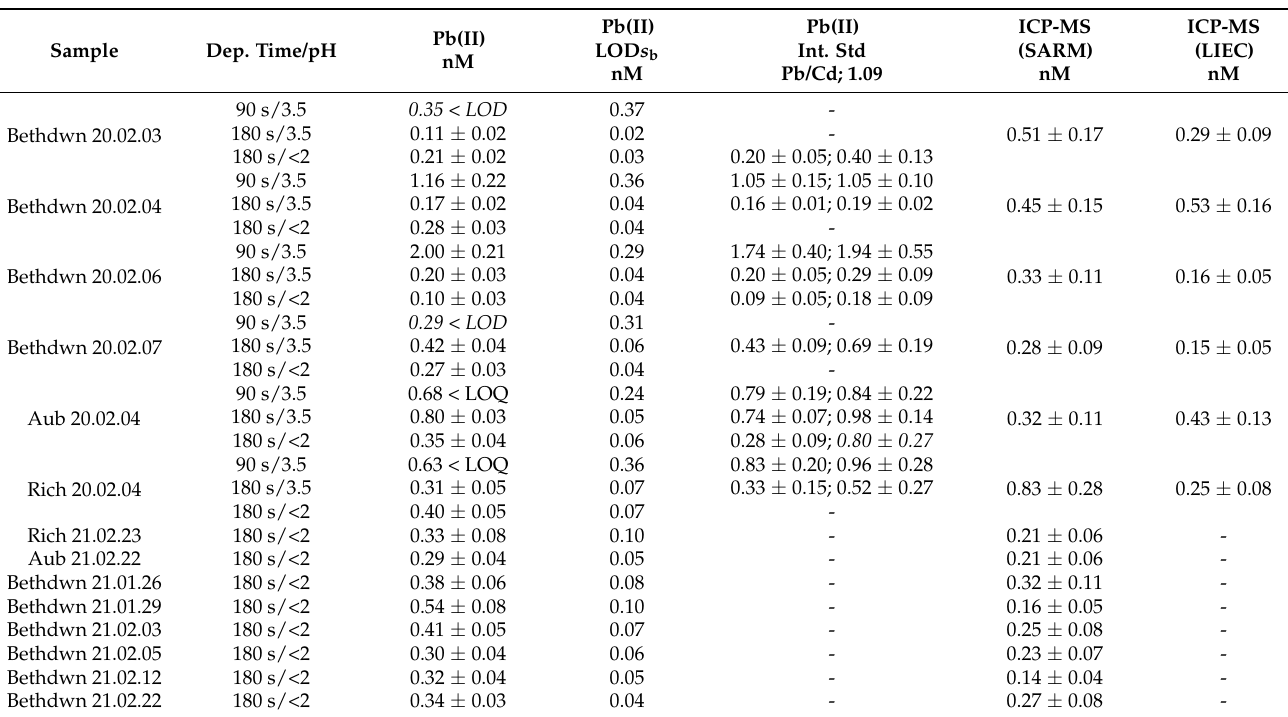
Table 7. Pb(II) results obtained for the standard additions and internal standard method at a deposition time of 90 s and 180 s in the filtered river samples at pH 3.5 are strongly acidified (<2) and its comparison with the ICP-MS results obtained in the strongly acidified